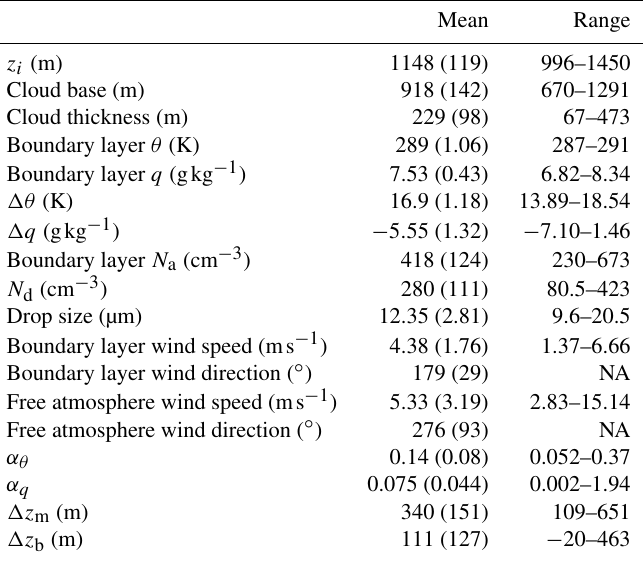
Figure 4. The range of the cloud (gray) and inversion (blue) layer as a function of altitude for each RF. The top of each gray profile represents cloud top and z i . The bottom of each gray profile represents cloud base. Cloud thickness (represented as a single value) is represented by each red dot (right y axis). The LCL and ECMWF z i are shown as the black star and green x, respectively. Table 2. Mean, standard deviation, and range of values for select variables over the 18 flights analyzed, with standard deviation values in